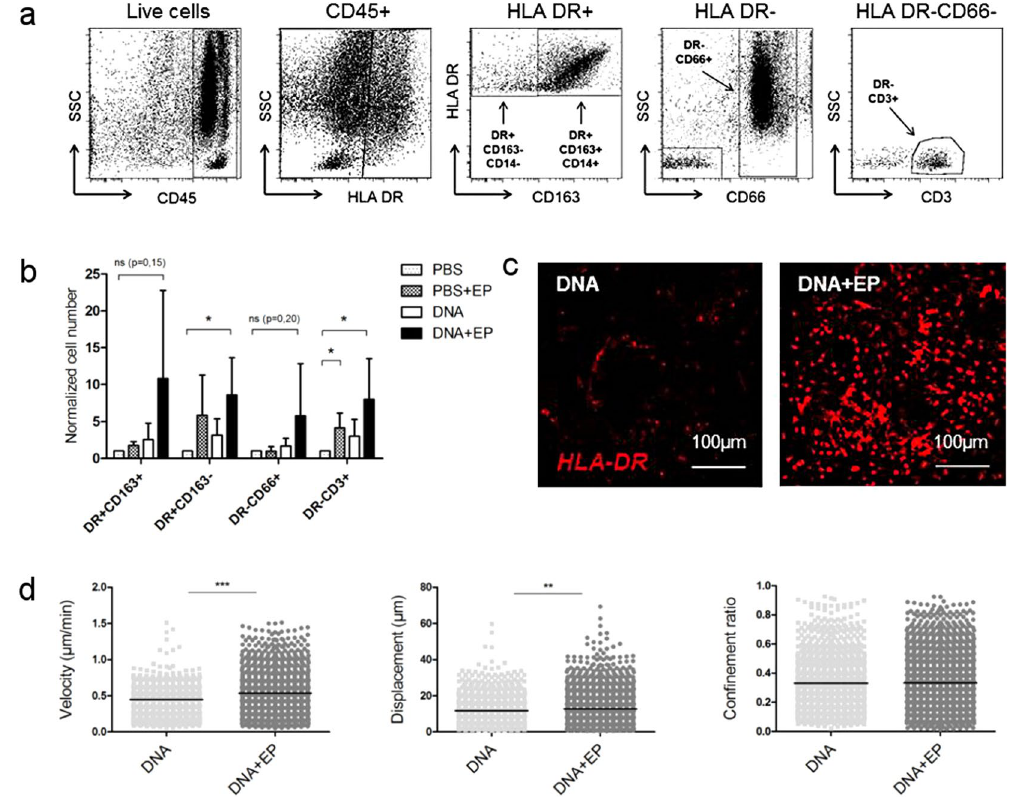
Figure 3. Characterization of immune infiltrates in the skin after EP or DNA + EP. ( a ) Skin cell suspensions were first gated for their morphology and viability. The gating strategy is shown on the skin of immunized macaque. Four cell populations of interest were analyzed: DR + CD163 + CD14 + (monocytes/macrophages), DR + CD163 − CD14 − (dendritic cells), DR − CD3 + (T lymphocytes) and DR − CD66 + (neutrophils). ( b ) Flow cytometry analysis of skin cell recruitment 24 h after vaccination (n = 5); cell number was normalized to absolute cell number after PBS injection. Friedman test. ( c ) Representative ex vivo confocal videomicroscopy images of HLA-DR labeled dermal APCs 24 h post-injection of DNA ± EP. ( d ) Analysis of dermal APC motility 24 h post-vaccination. Each point represents one cell (n = 3). Mann–Whitney test. Data are presented as mean ± SD; * p < 0.05; ** p < 0.01; *** p < 0.001; EP,